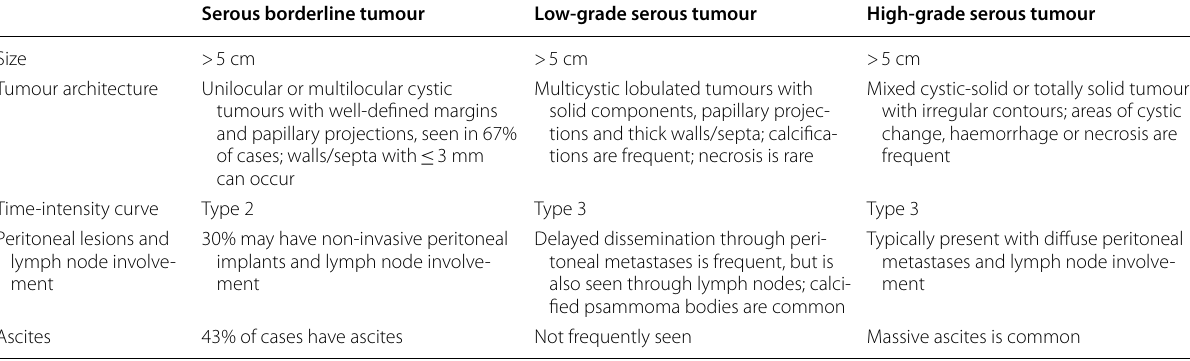
Table based on the literature review [1–3, 5–8, 14, 24,